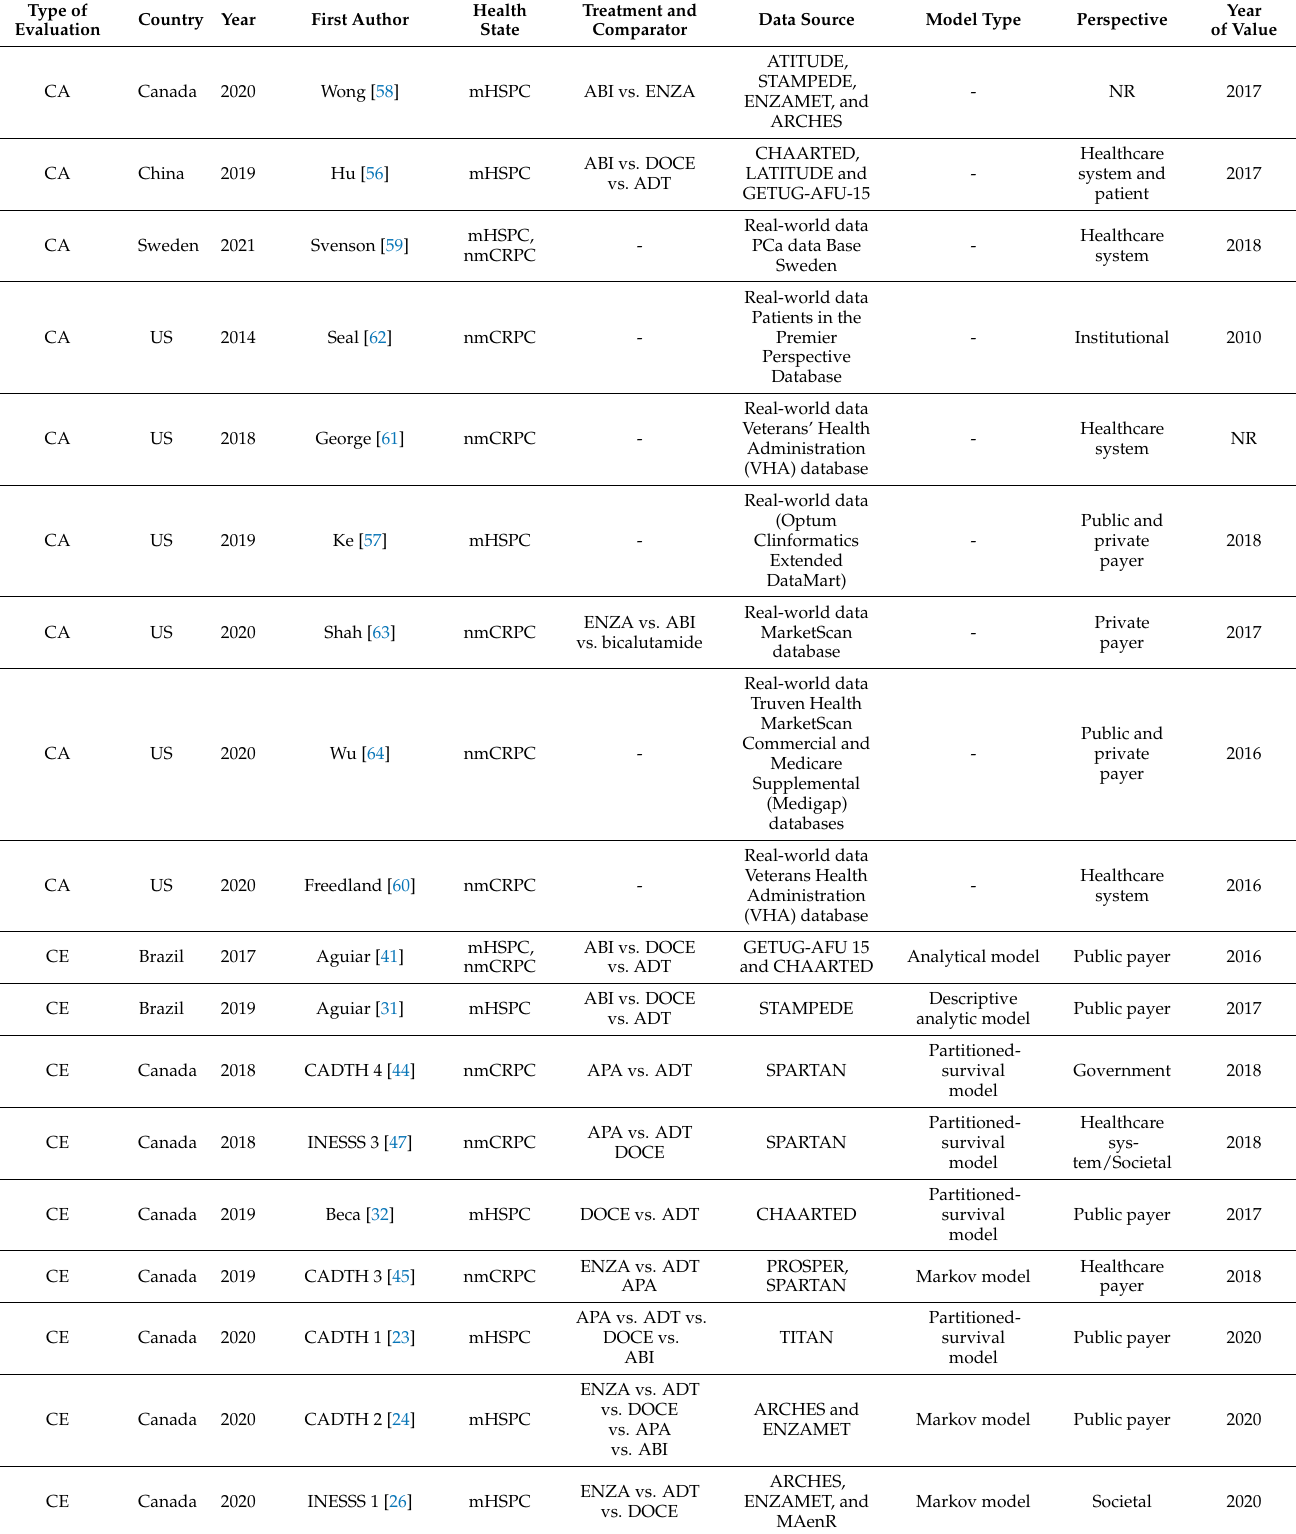
Table 1. Characteristics of retained economic